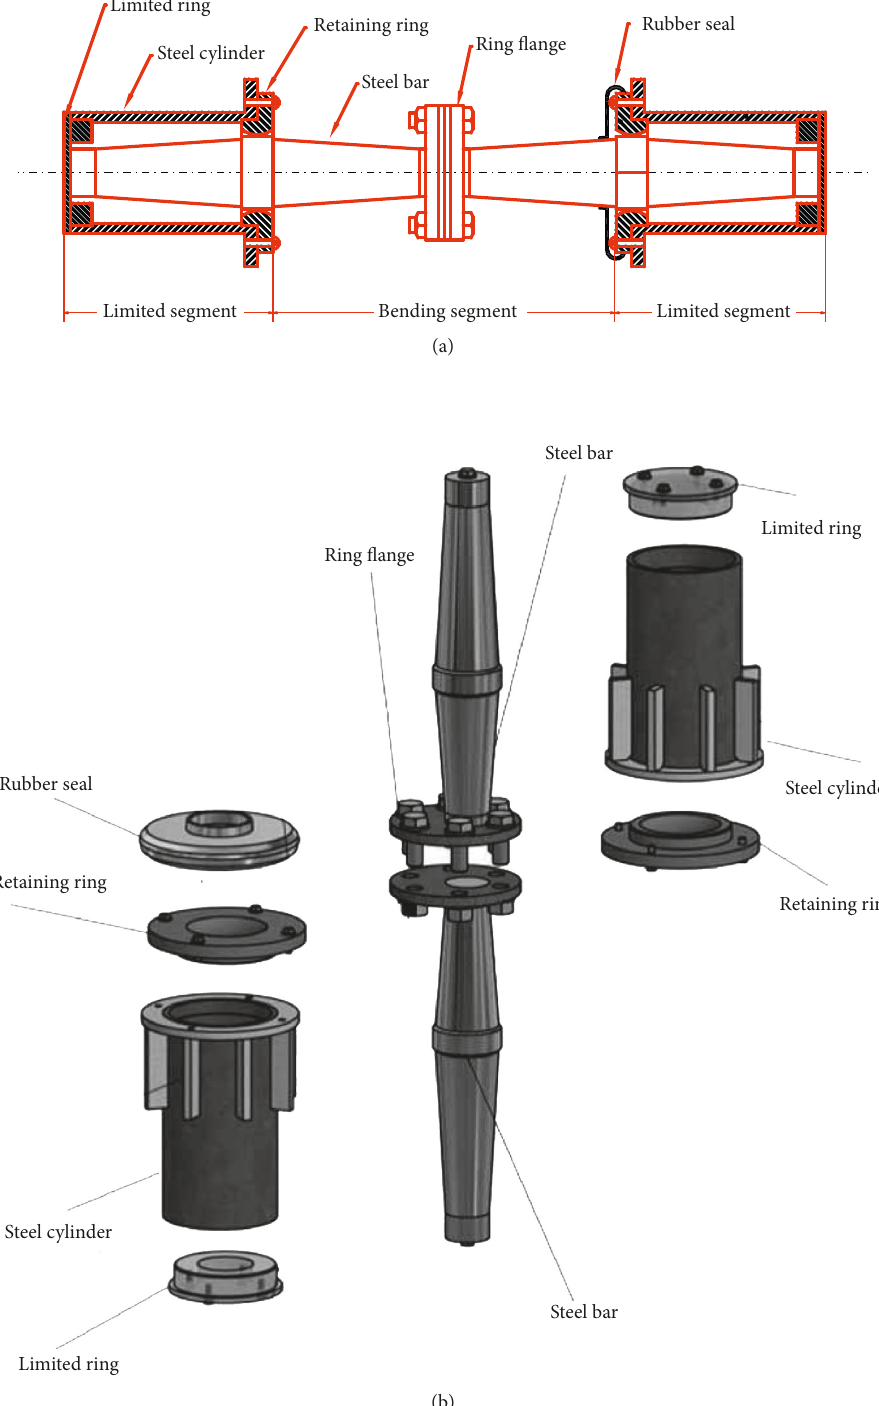
Figure 1: Structure of the developed shock-absorbing device. (a) Details of the device. (b) Disassembly diagram of the